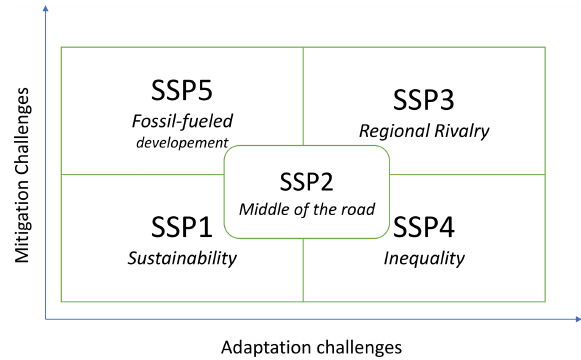
Figure 13. SSP matrix O’Neill et al. (2017) (based on O’Neill et al., 2014, Fig. 1, inspired by Kriegler et al., 2012, Fig.